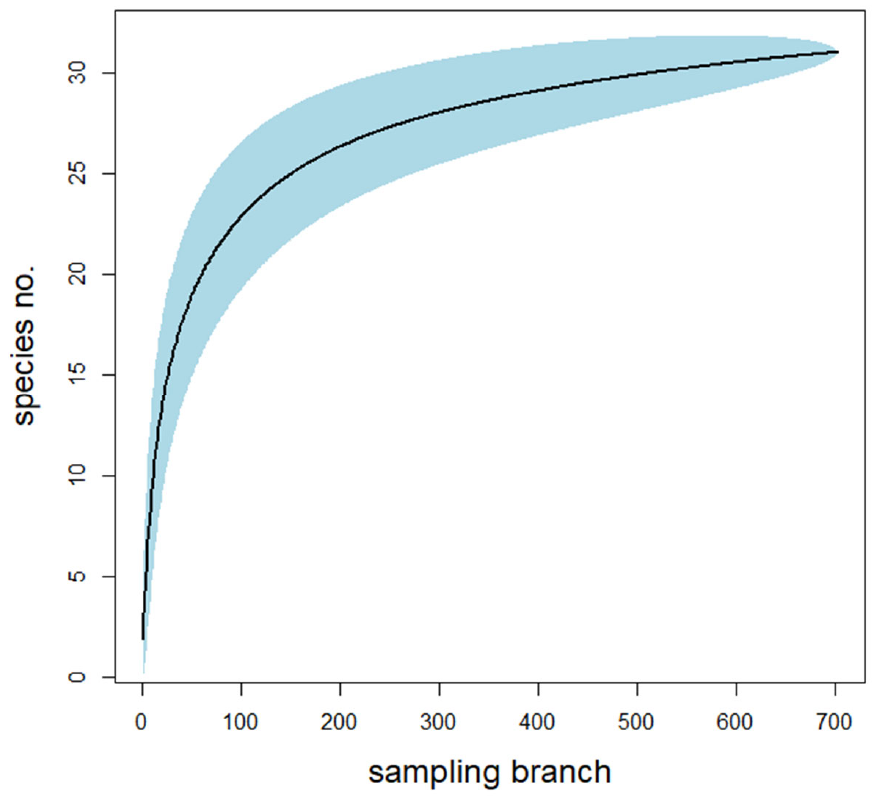
Figure 5. The species accumulation curve (SAC) of epiphytic plants in this study, using presence– absence data of the 31 holo-epiphytic species on all branches of the twenty sample trees.